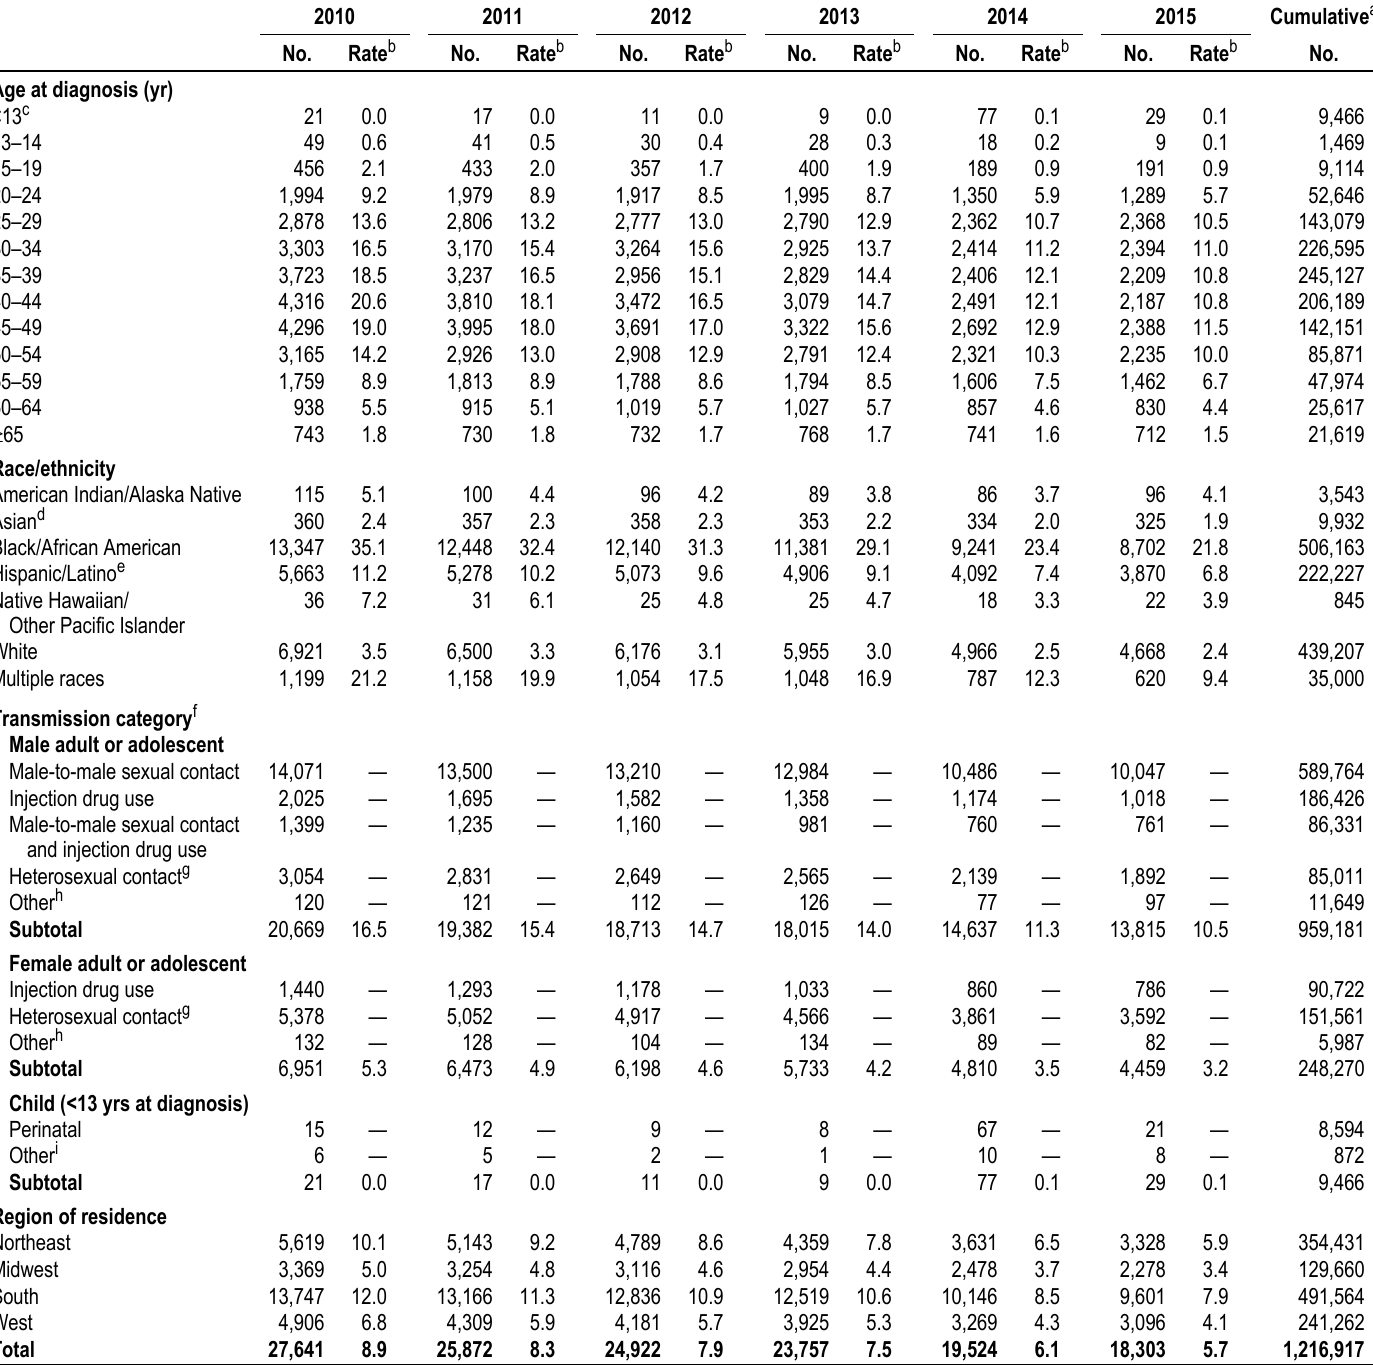
Table 2a. Stage 3 (AIDS), by year of diagnosis and selected characteristics, 2010–2015 and cumulative—United